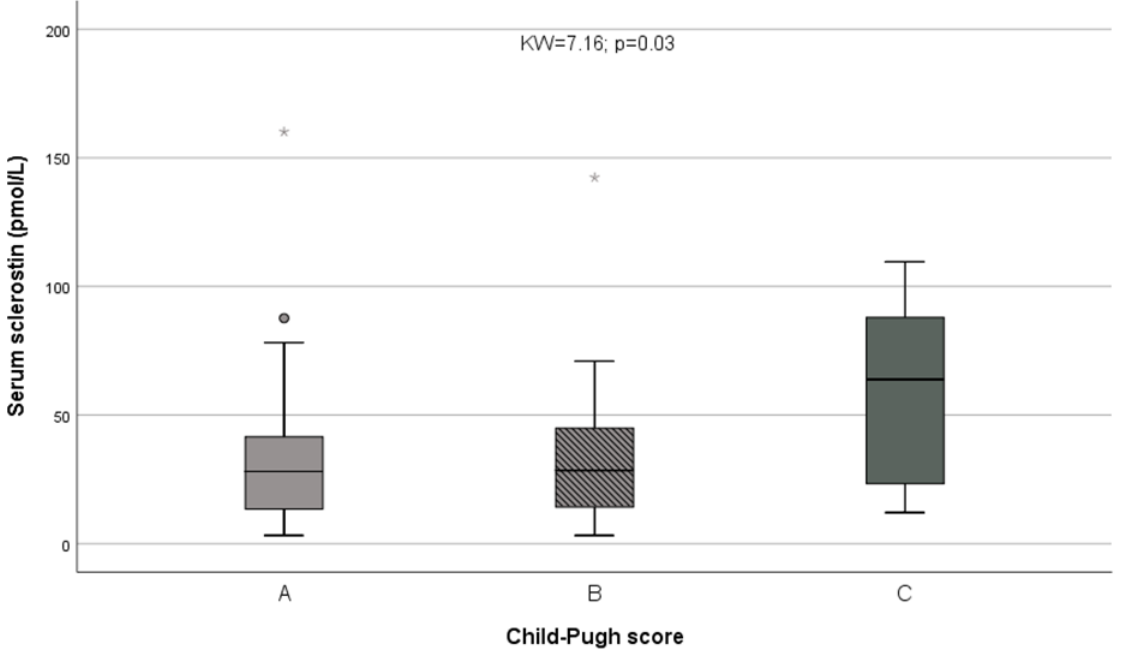
Figure 1. Differences in serum sclerostin levels among Child A, Child B and Child C patients. * = * = represent extreme represent extreme values.